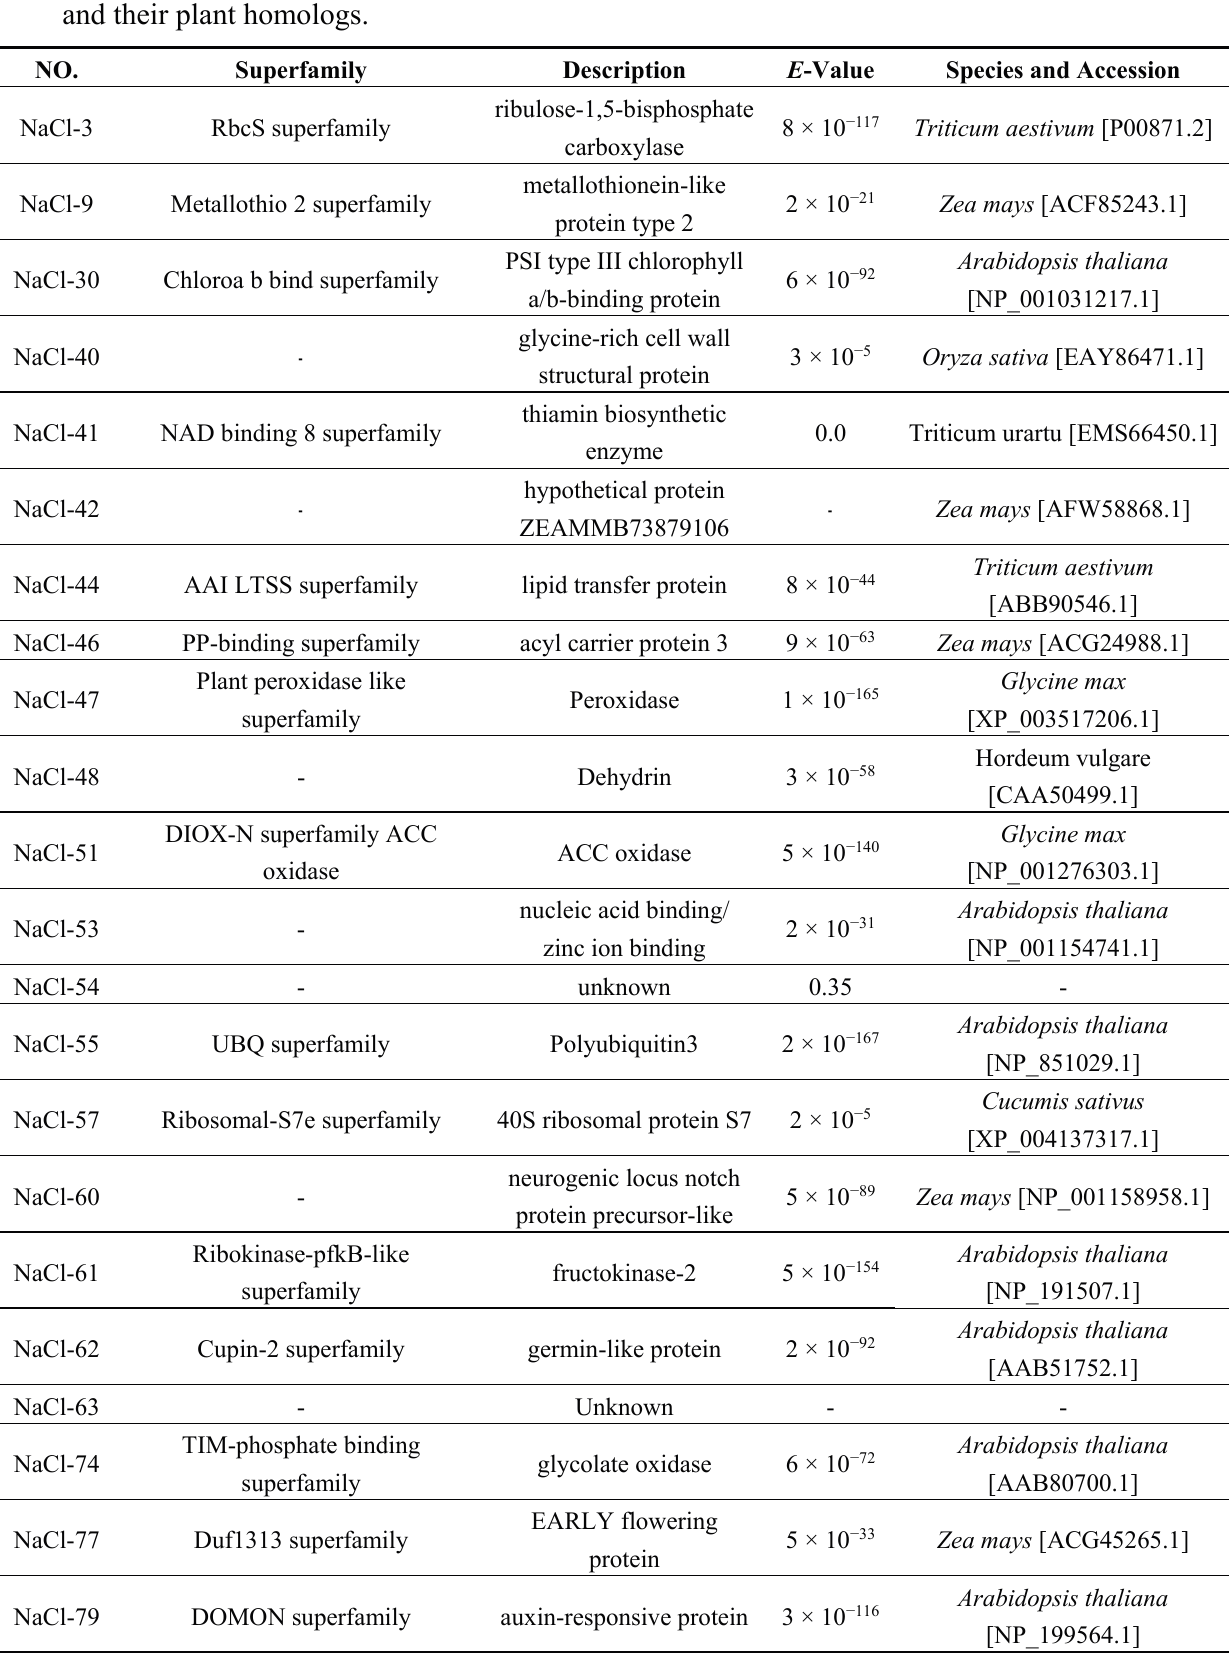
Table 2. Full-length cDNAs of P. tenuiflora isolated from the salt-tolerant transgenic yeast and their plant